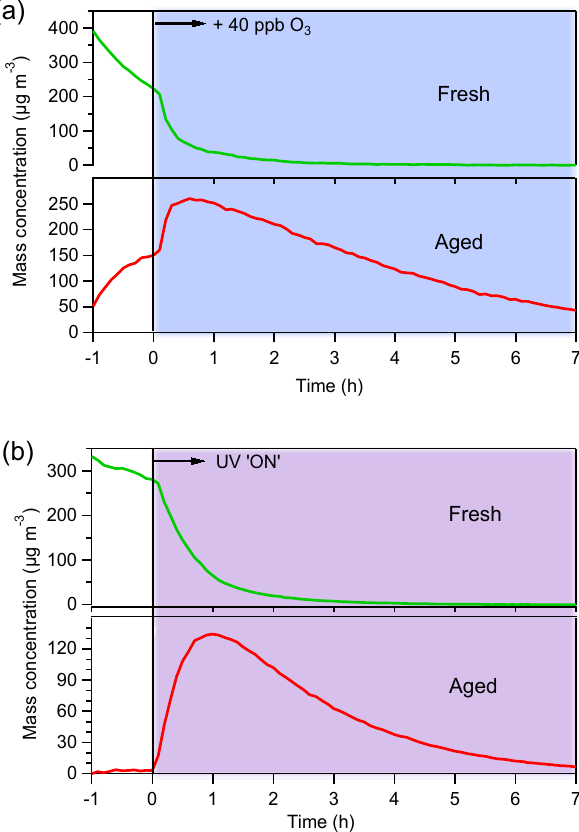
Figure 6. (a) Ozone and estimated OH radical ( m/z 66 corresponds to d-butanol) concentrations in Experiment 2 (UV illumination) and (b) ozone concentration during Experiment 3 (dark ozonolysis).